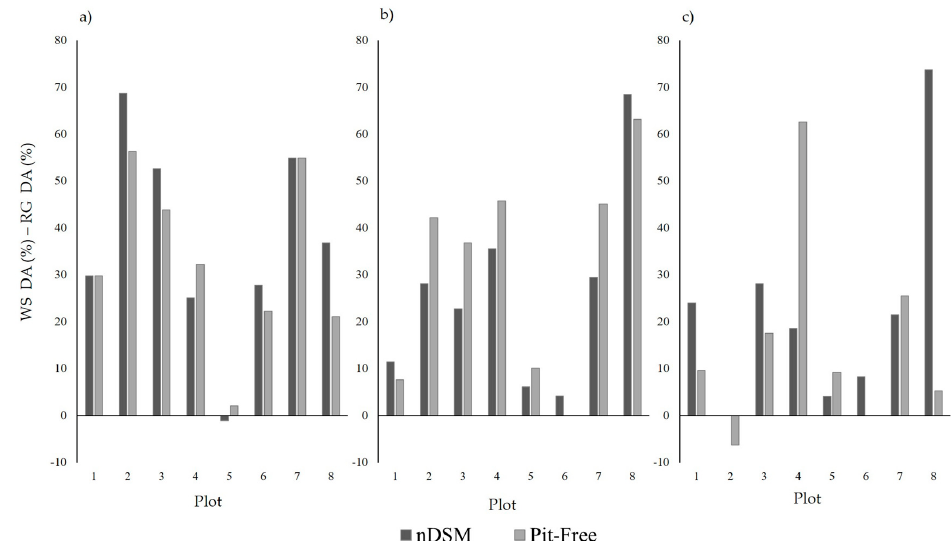
Figure 6. The difference between marker-controlled watershed (WS) and region growing (RG) segmentation delineation accuracy (DA) percentages for each of the CHM generation methods (standard and pit-free) across the: ( a ) 0.15 m; ( b ) 0.25 m; and ( c ) 0.5 m pixel sizes. Table 10. p values from the Wilcoxon signed rank test after Holm–Bonferroni correction, comparing results from the two segmentation algorithms (marker-controlled watershed and region growing).